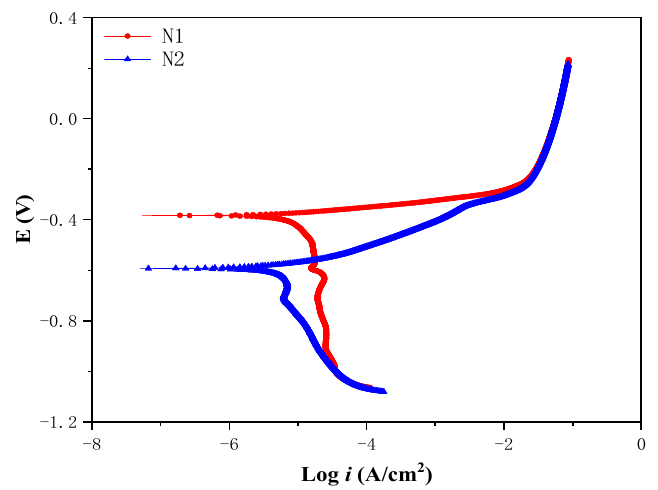
Figure 7. Mechanical properties of N1 and N2 steels under different tempering temperature: ( a ) tensile strength; ( b ) yield strength; ( c ) elongation.